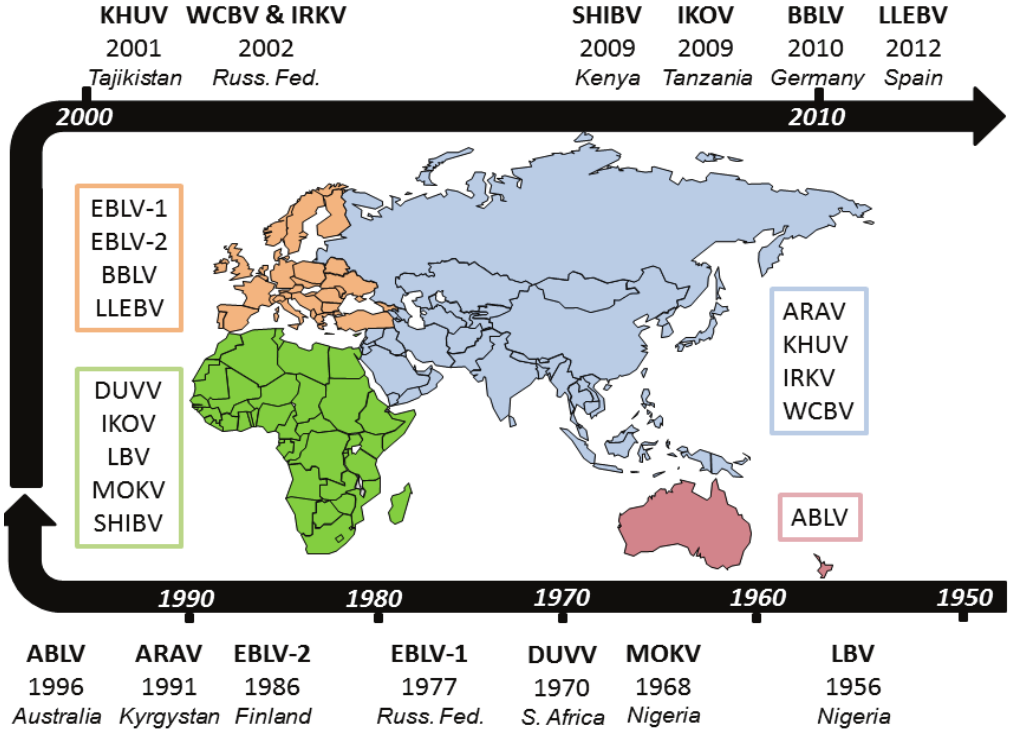
Figure 2. A Lyssavirus timeline. Acronyms are as detailed in Table 1. Regions where different lyssaviruses are found are coloured and dates for initial isolations are